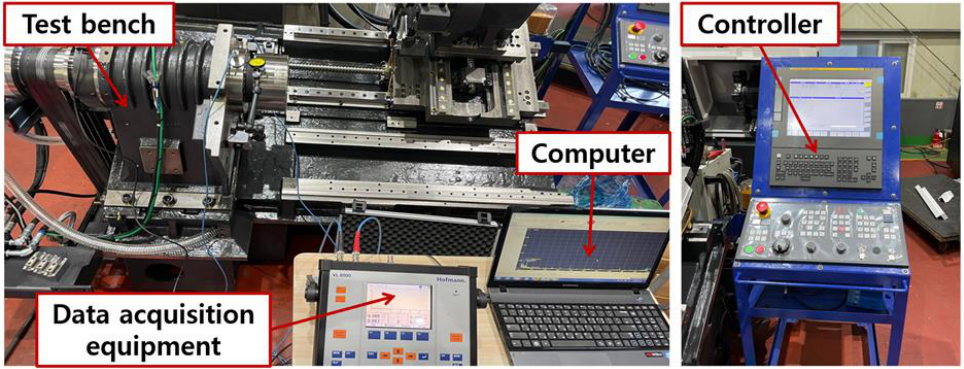
Figure 4. Experimental arrangement for vibration experiment.